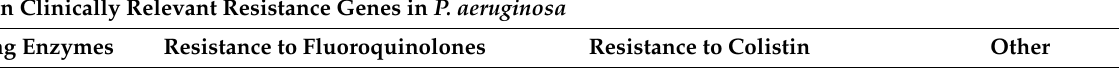
Table 2. Overview of the most common resistance genes of high-risk P.